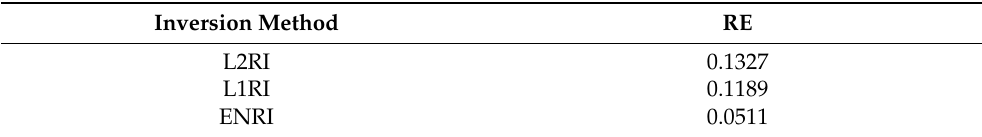
Table 1. The REs of inverted reflectivity series by different methods.